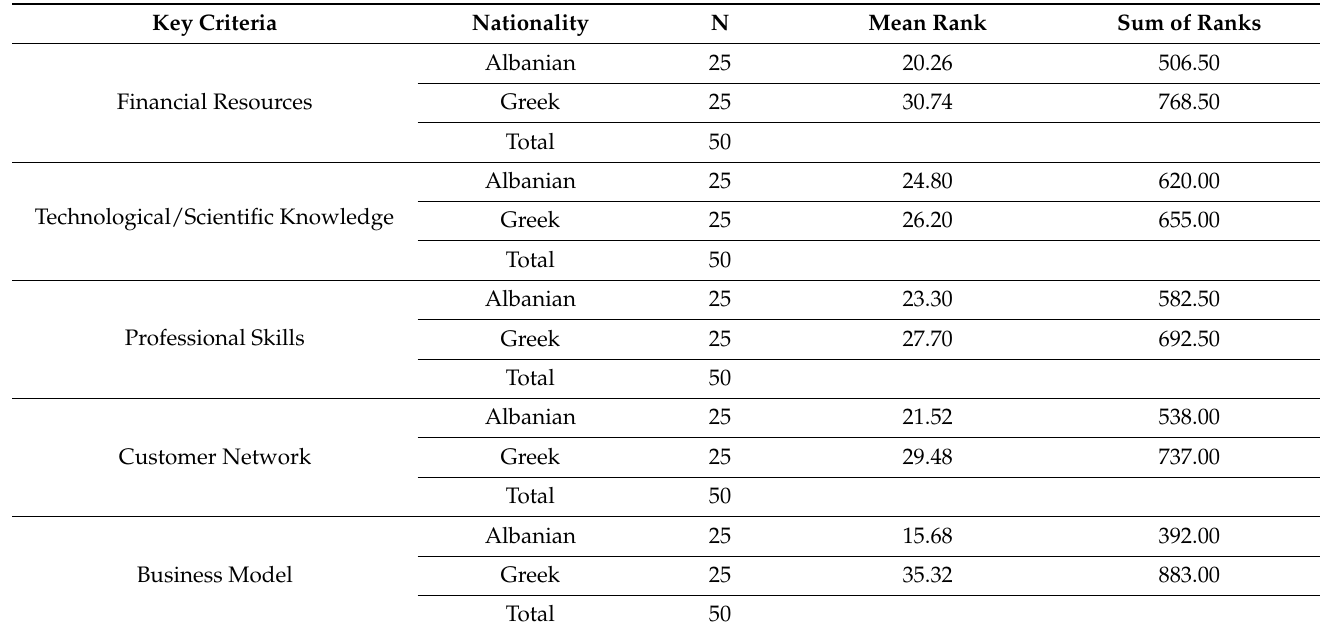
Table 5. Mean Ranks of key criteria contributing to business